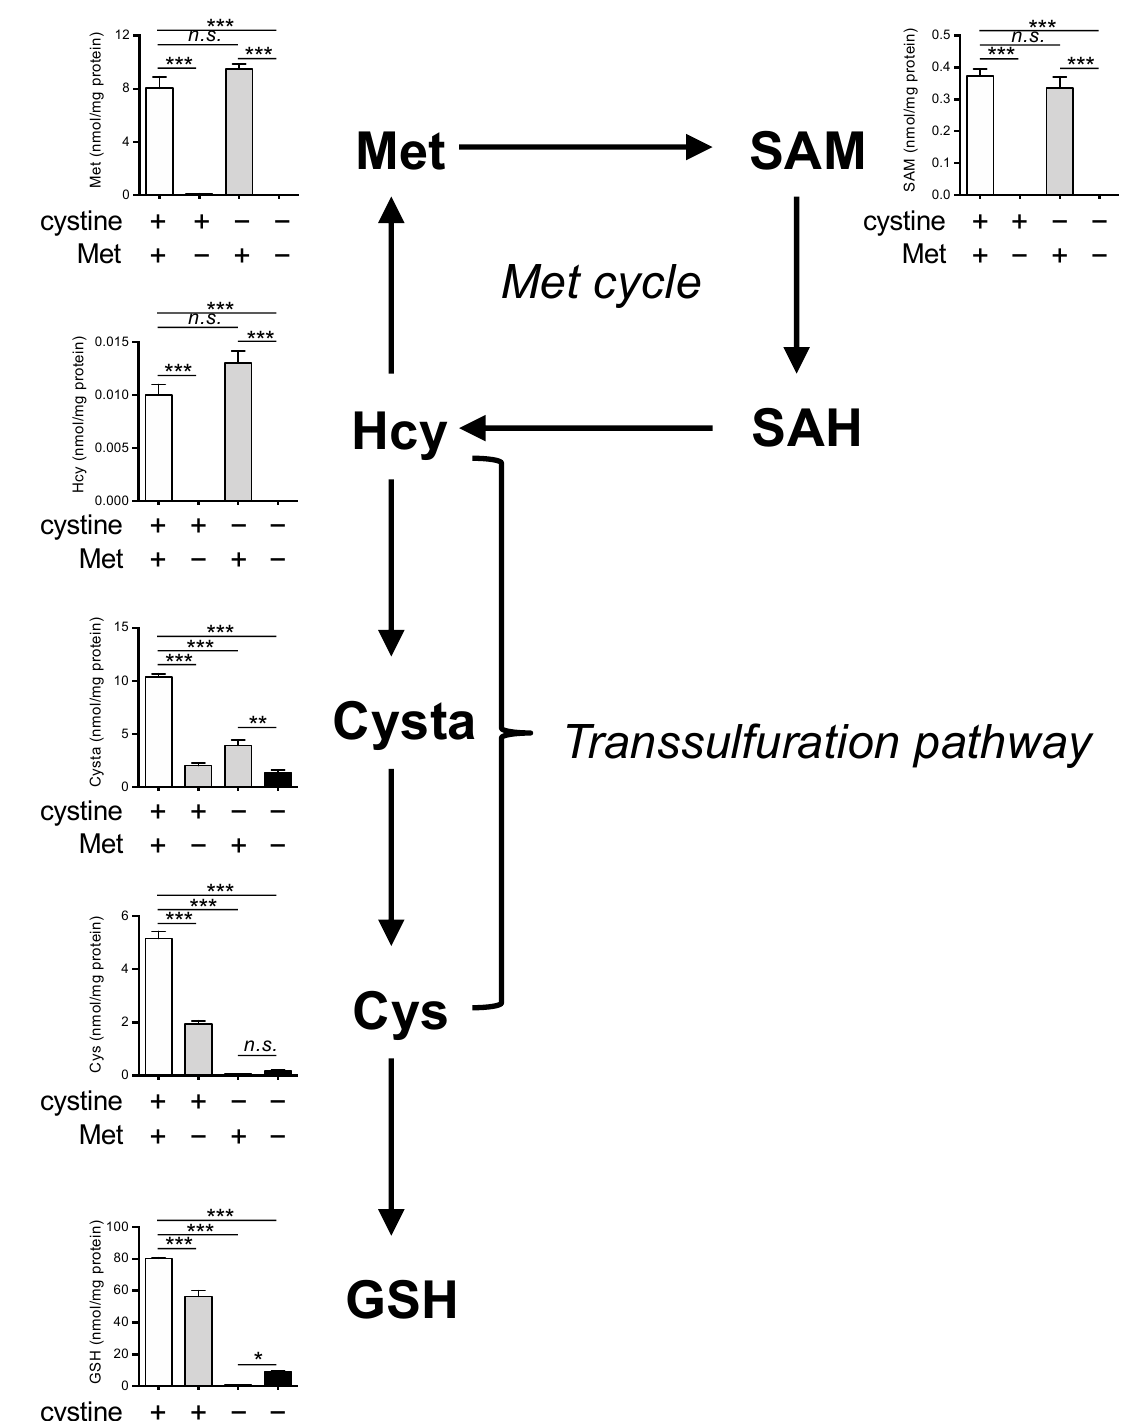
Figure 2. Effects of Met/cystine double deprivation on Met-cycle metabolites. Intracellular concentra- tion of Met, SAM, SAH, homocysteine (Hcy), cystathionine (Cysta), Cys and GSH in HeLa cells 24 h after culture in complete (control), Met-free, cystine-free, or Met/cystine double-free medium. The SAH levels were below detectable levels in our assay method. Data are presented as the mean ± SEM ( n = 3). *: p < 0.05, **: p < 0.01, ***: p < 0.001 (Tukey’s test). n.s.: not